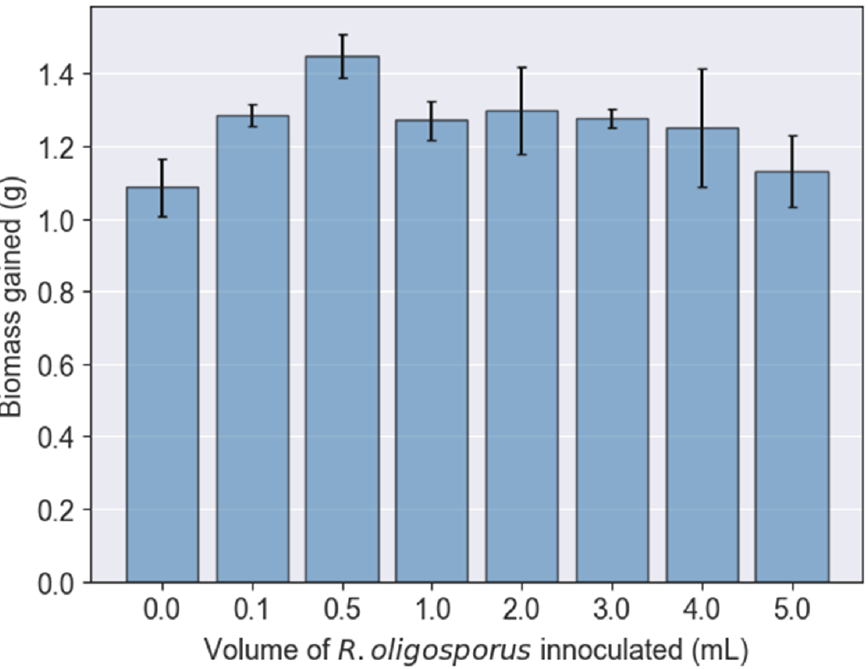
Figure 1. Total weight of biomass gained by black soldier fly larvae fed palm kernel expeller containing various inoculation volumes of R. oligosporus .